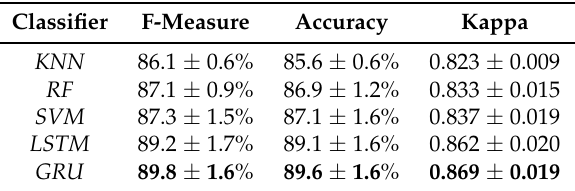
Table 2. The average and standard deviation from cross-validation 5 times on the time series SAR Sentinel-1